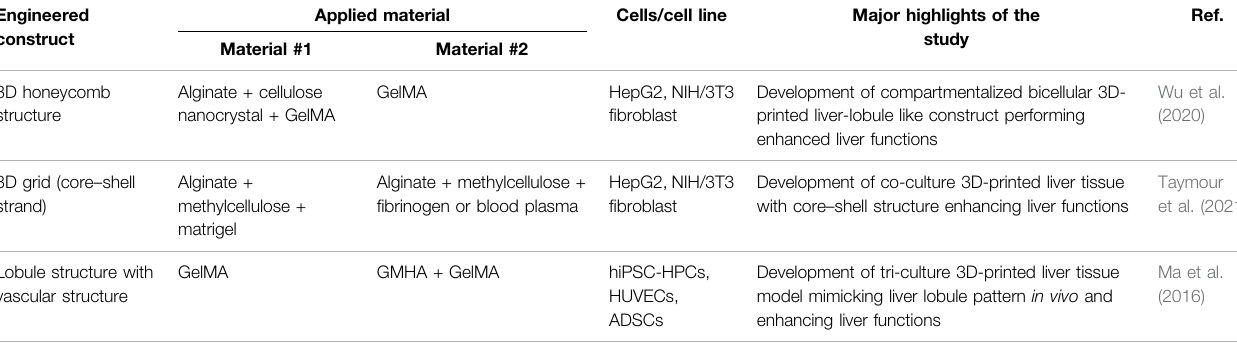
TABLE 4 | Hybrid structure of multicomponent bioink-based 3D-printed liver tissue models for liver regeneration models. Engineered